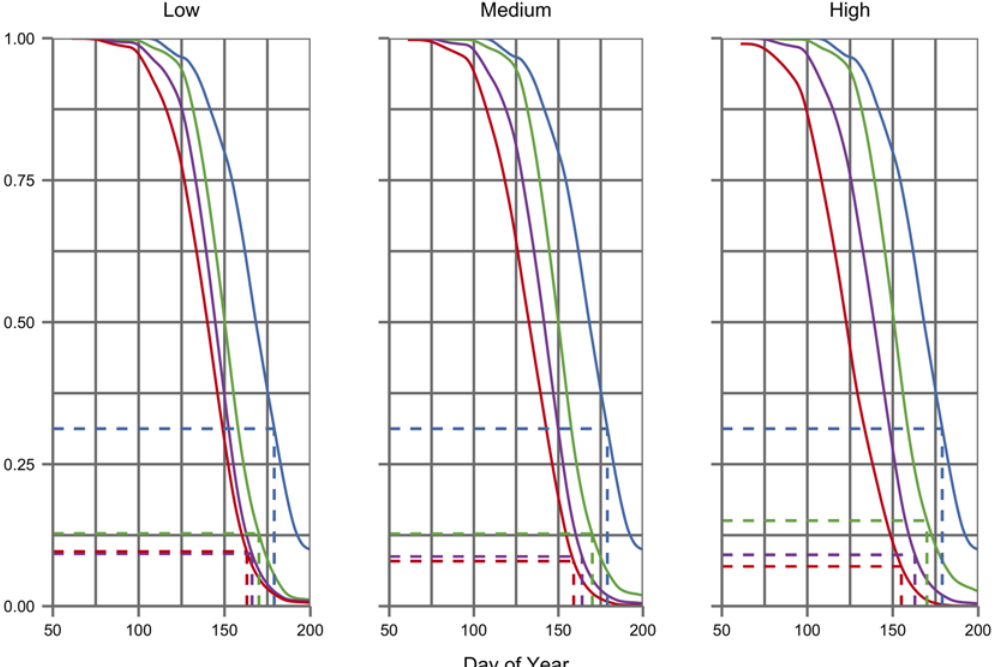
Fig 5. Risk profiles of adverse flowering weather (defined as 10 or more of the 14 days after flowering with daily mean temperatures < 15°C or > 5mm precipitation) under baseline (blue) and three future time periods (green 2010 – 39, purple 2040 – 69, red 2070 – 89) for low, medium and high emissions scenarios (from left to right). Dotted lines indicate the mean budbreak date, calculated using a spring warming models [60, 62], and the corresponding risk of adverse flowering weather under each scenario and time period.